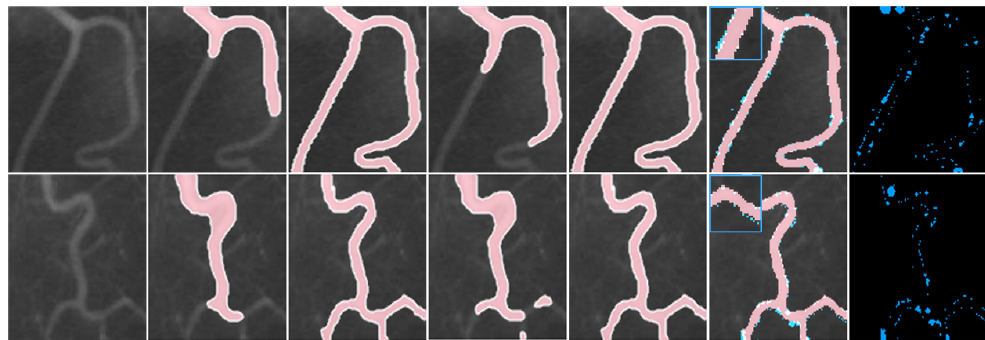
Figure 3. The comparison results on medial images. The first column is the images to be segmented, the middle five columns are the segmentation result of the five methods (CV [8], RSF [11], FEBAC [15], RLSF [31], and ours) and the last column is the uncertainty degree generated by our method.